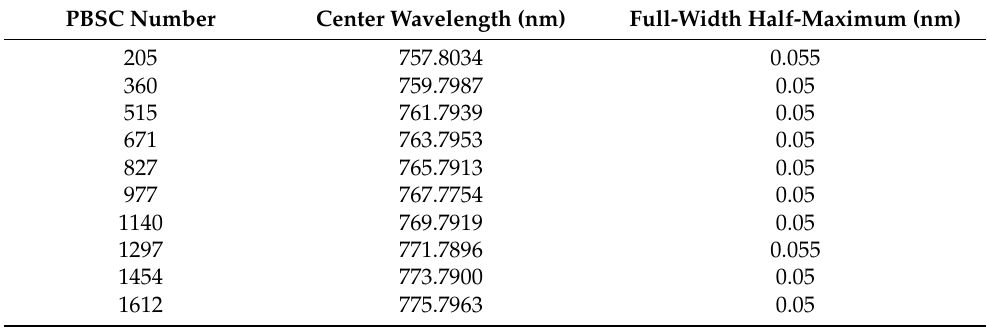
Table 3. Spectral calibration results of molecular oxygen A-band with observation channel (channel 2).